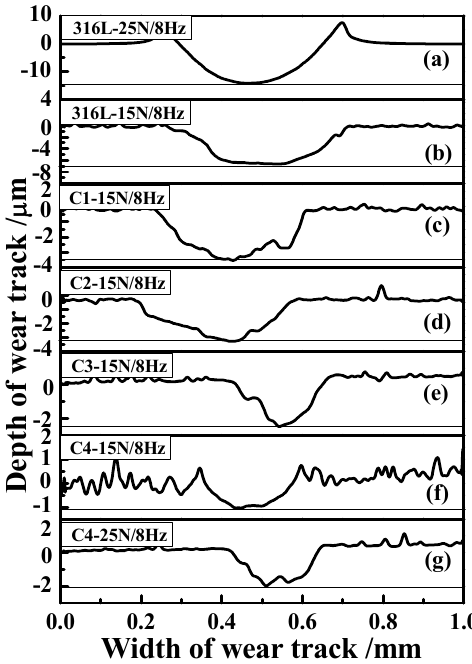
Figure 10. The cross-sectional profiles of wear track on 316L substrate and CrN films: ( a , b ) 316L; ( c ) C1; ( d ) C2; ( e ) C3; ( f , g ) C4. Materials 2018 , 11 , x FOR PEER REVIEW